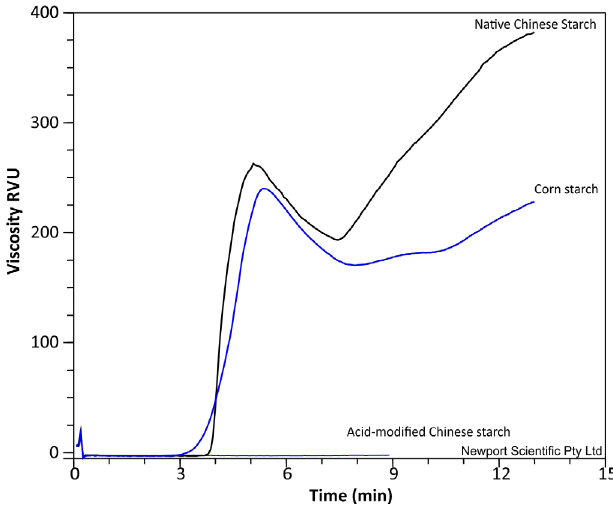
FIGURE 1 - Viscosity profile of